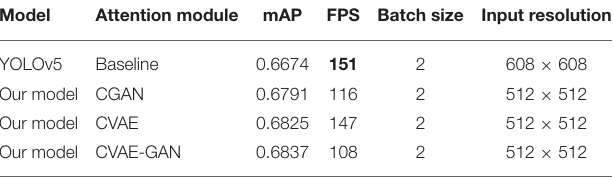
TABLE 3 | Comparison of variant models and our model.